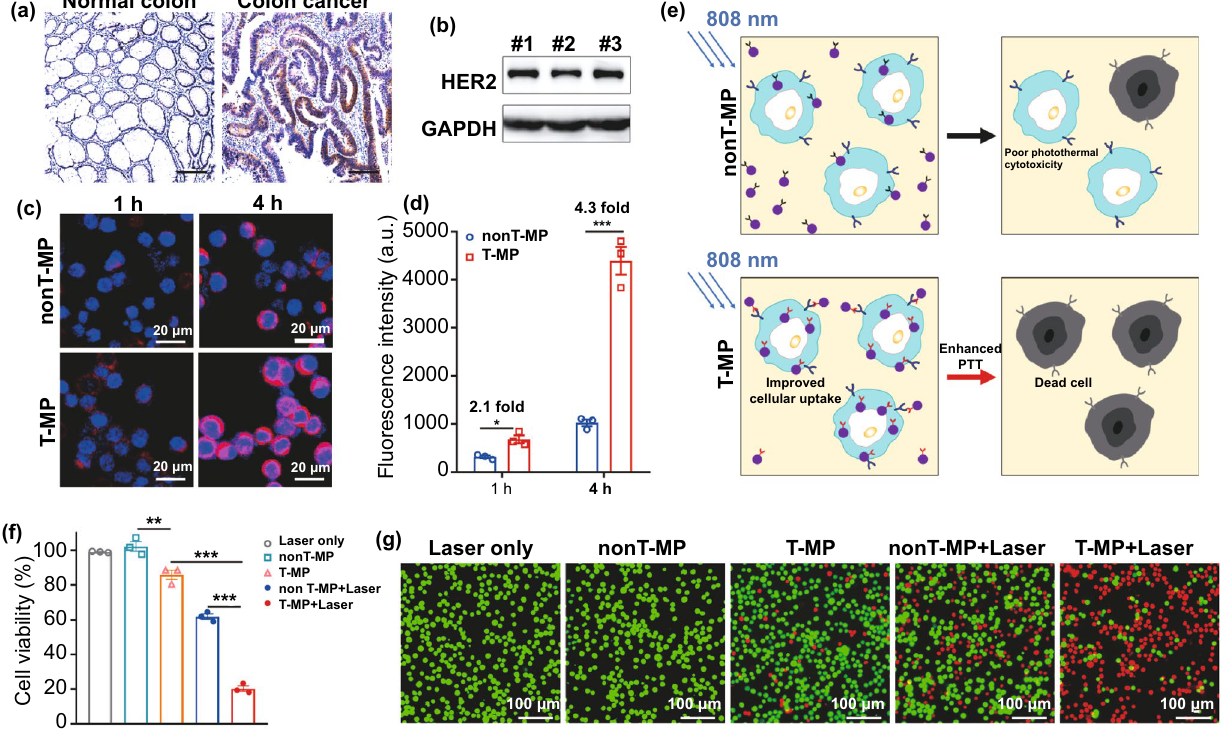
Fig. 2 Targeted cellular uptake and improved photothermal‑induced cytotoxicity. a Representative immunohistochemical staining showing high HER2 expression in colon cancer from human patients, compared to human normal colon tissues. b Western blot analysis for HER2 expres‑ sion in HT‑29 cells. #1, #2, and #3 are three replicated samples. GAPDH (glyceraldehyde‑3‑phosphate dehydrogenase) was used as control. c Confocal fluorescence images of cellular uptake in HT‑29‑luc cells after 1 and 4 h‑incubation with iFluor 594‑labeled micelles ( E x 563 nm, E m 604 nm). d iFluor 594 fluorescence intensity in HT‑29 cells analyzed by ArrayScan XTI High Content Analysis Reader. e Illustration showing how improved cellular uptake conferred by targeted antibody modification enhances photothermal‑induced cytotoxicity. f Cell viability after treatment with micelles and laser irradiation. Micelles or laser alone were included as control. g Fluorescence microscope images of calcein‑ AM/PI co‑stained HT‑29‑luc cells after various treatments. Live and dead cells were shown in green (Calcein‑AM; E x 490 nm, E m 515 nm) and red (PI; E x 530 nm, E m 580 nm), respectively. Data are presented as mean ± s.d. ( n = 3). * p < 0.05, ** p < 0.01, *** p <